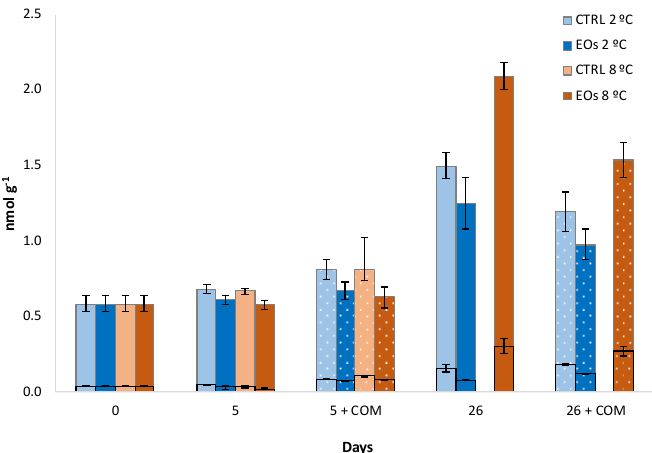
Figure 2. MACC and free ACC (black squared bars) contents during cold storage periods (2 and 8 ◦ C) and complimentary commercialization simulations (COM; 4 days at 22 ◦ C) for flat peaches with or without active paper sheets (including β CD-encapsulated EOs) ( n = 3 ± SD). Samples showed an initial ACO level of 0.037 nmol ethylene g −1 h −1 (Figure 3), which is in